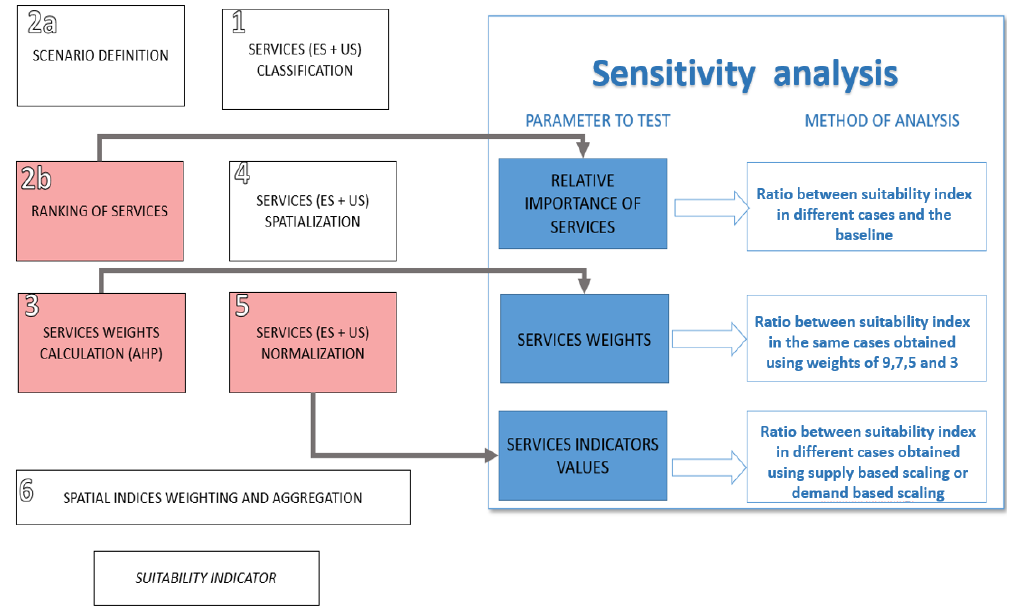
Figure 3. Methodological approach to sensitivity analysis (pink rectangles: sources of variability of SUSAM, blue rectangles: methodological steps of sensitivity